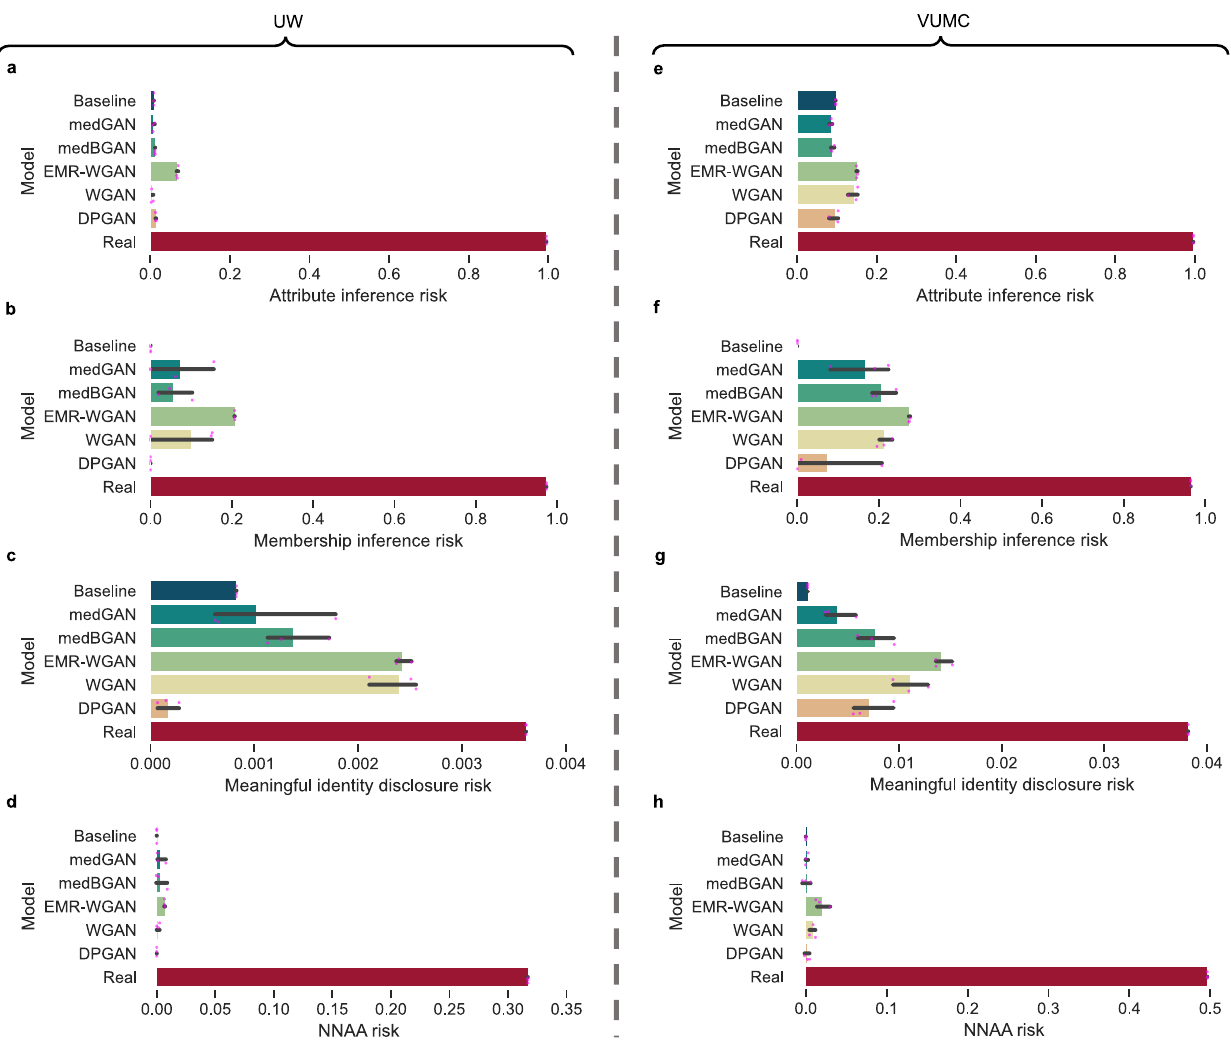
(NNAA) risk. The risks associated with the real data are shown in the bottom red bars. The 95% con fi dence intervals are marked as thin horizontal black